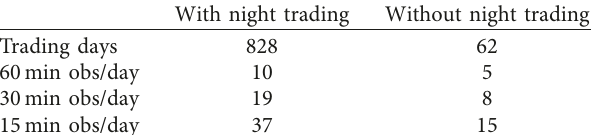
Table 1: High-frequency observations in different